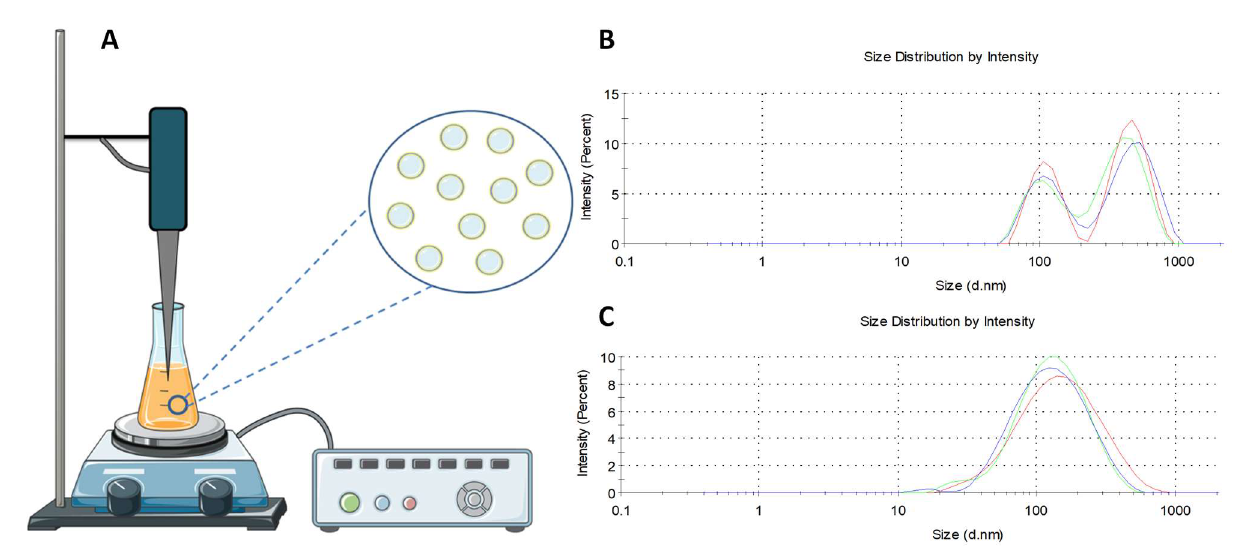
Figure 12. Schematic representation of set for the alternative method of liposome extrusion ( A ). The size of the liposomes with curcumin was measured with dynamic light scattering (DLS)—hydrated and untreated ( B ) and extruded using an ultrasonic UV 2070 homogenizer with an MS 73 head ( C ).